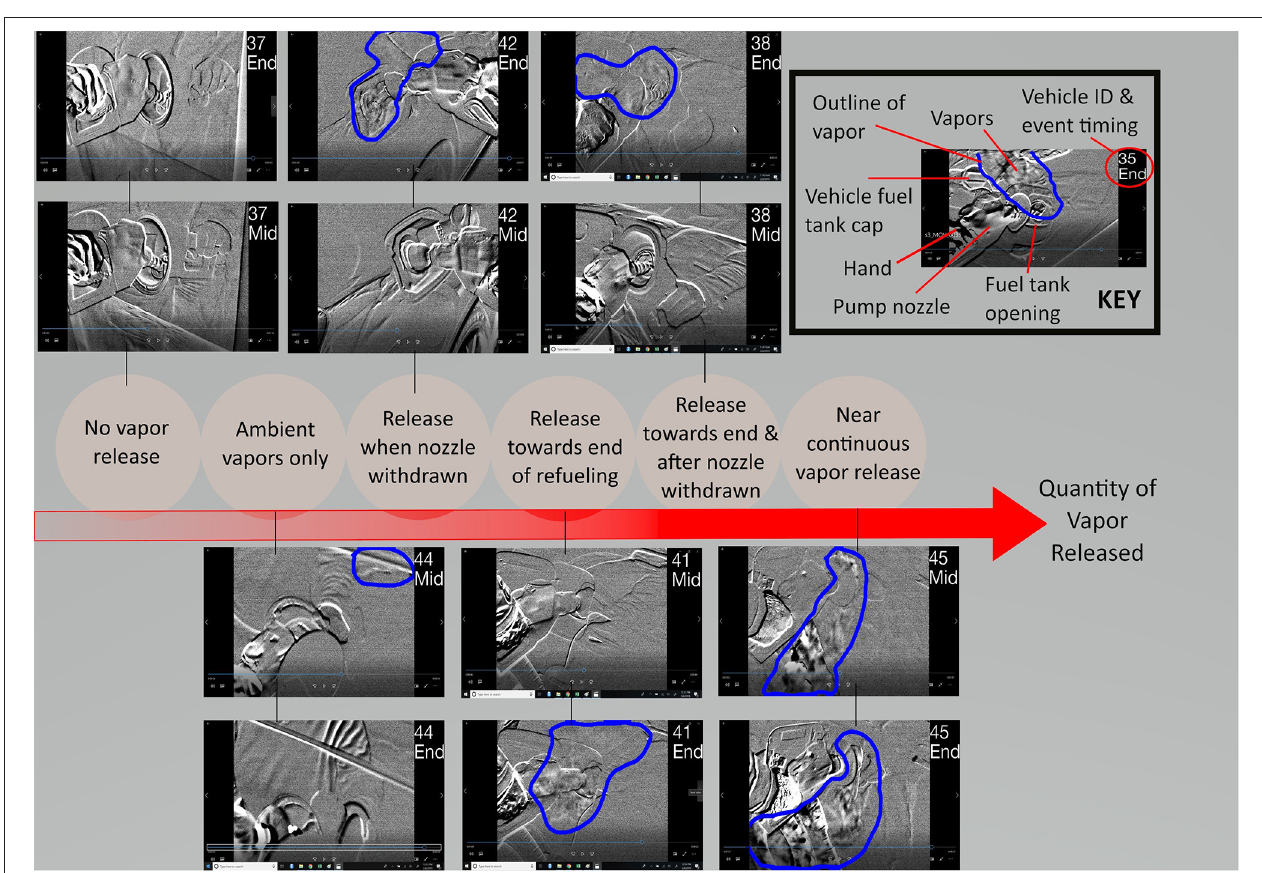
FIGURE 2 | Two sample frames for each of the 6 identified patterns of vapor release during refueling: one during the middle of the refueling session, and one at the end. Vehicle ID and an indicator for middle (“Mid”) or end (“End”) of the video are included in the upper right corner of each photo. Gasoline vapors, when present, are outlined by a blue